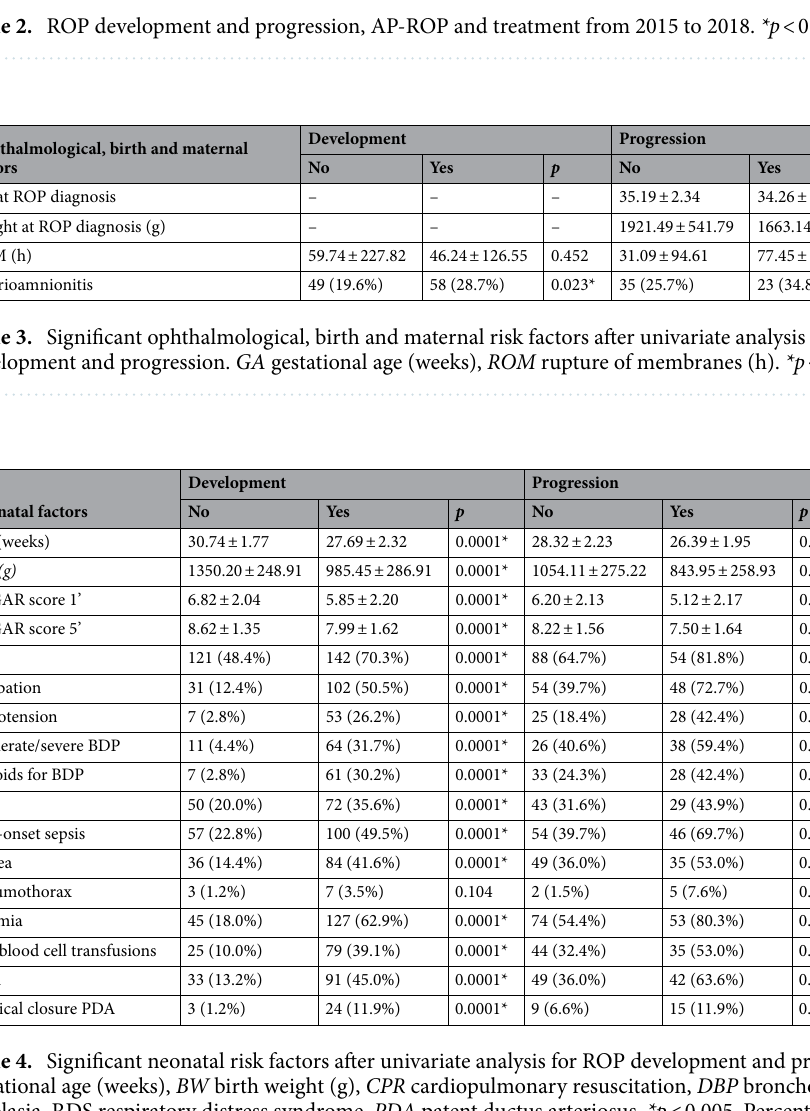
Table 4. Significant neonatal risk factors after univariate analysis for ROP development and progression. GA gestational age (weeks), BW birth weight (g), CPR cardiopulmonary resuscitation, DBP bronchopulmonary dysplasia, RDS respiratory distress syndrome, PDA patent ductus arteriosus. *p < 0.005. Percentages refer to children with the risk factor.